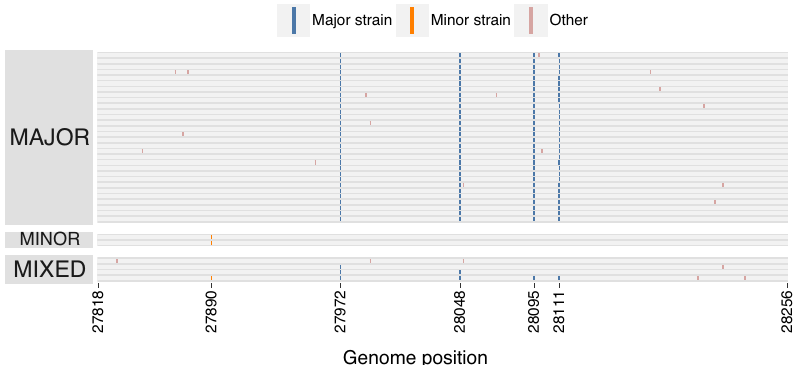
Fig. 5 Major, minor, and mixed haplotypes in the 476 nucleotide ORF8 cloned sequences. Each row represents a sequenced clone ( n = 36). Colored markings denote mutations from the reference genome. Major strain mutations are those found in the Alpha variant. Minor strain mutations are those found in Epsilon variant. Other mutations are found at intermediate or low frequencies.